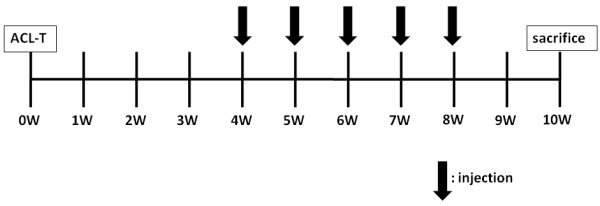
Protocol. Intra-articular injections were commenced from week 4 after preparation of the osteoarthritis (OA) model. Treatment solutions were injected once weekly until week 8. The rabbits were killed 10 weeks after surgery. Surgery and intra-articular injections were performed with the rabbits under general anesthesia. ACL-T, anterior cruciate ligament transection.